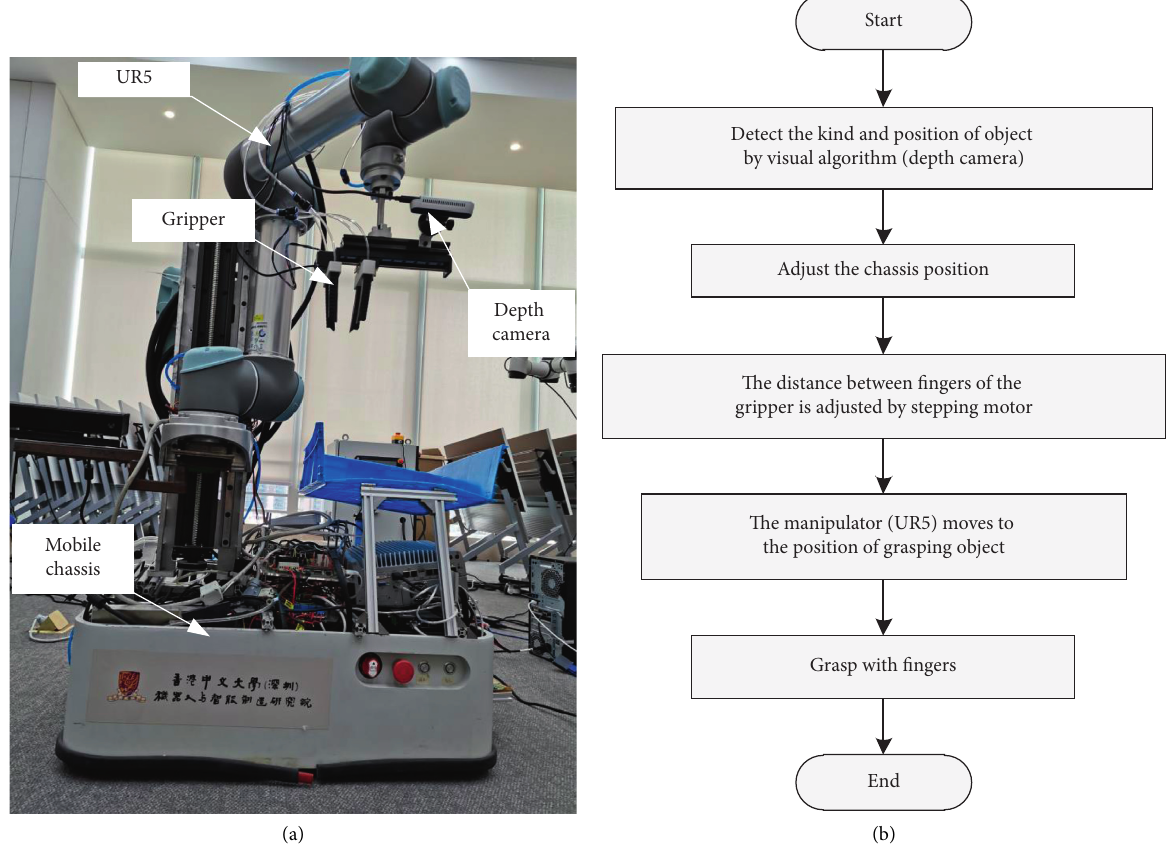
Figure 2: Grasping function of the mobile robot. (a) Mobile grasping robotic system. (b) Robot grasping flow chart.